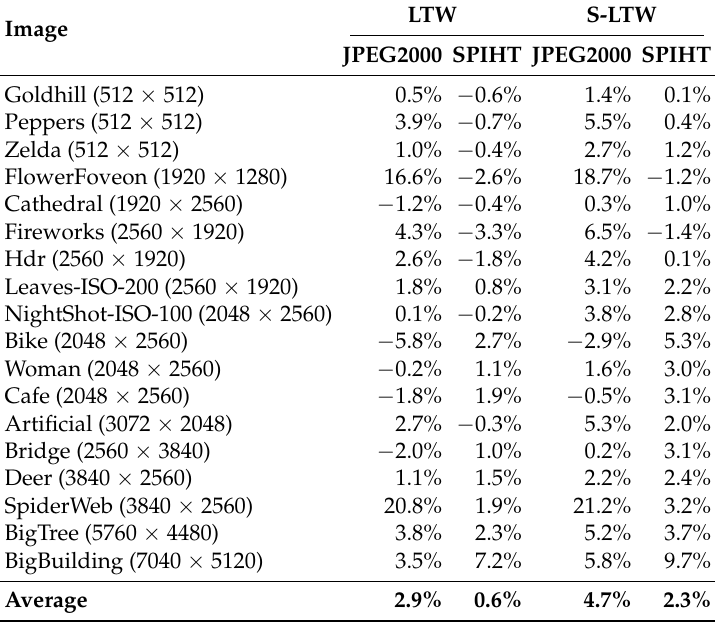
Table 6. %BD-Rate comparison between LTW and S-LTW respect to JPEG2000 and SPIHT for all tested